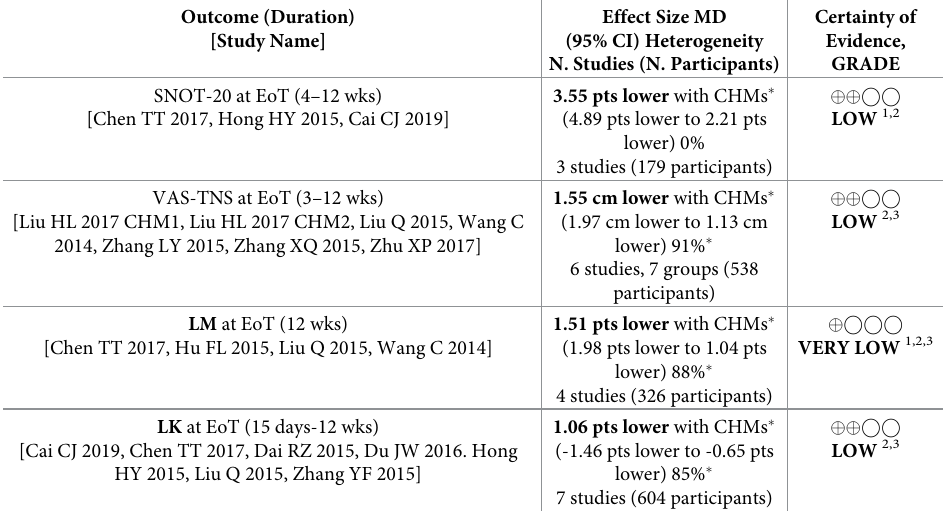
Table 6. GRADE for oral Chinese herbal medicine plus pharmacotherapy versus pharmacotherapy for chronic rhinosinusitis: All studies. Outcome (Duration) [Study Name]